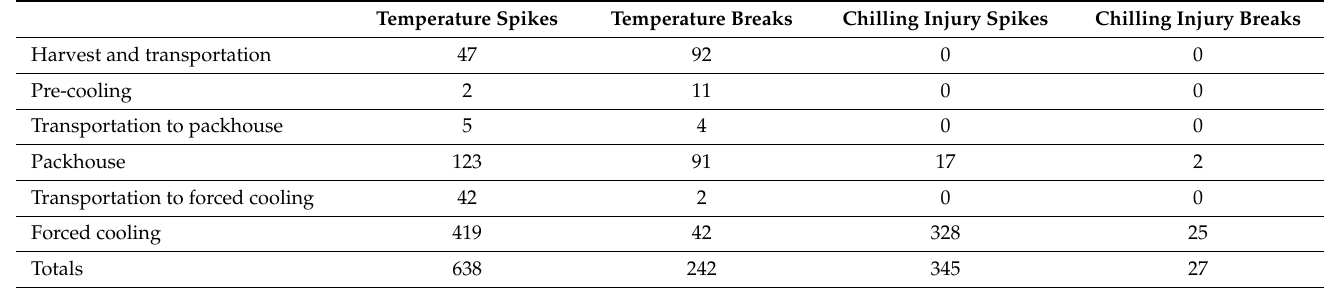
Table 4. Number of temperature and chilling injury spikes and breaks recorded per